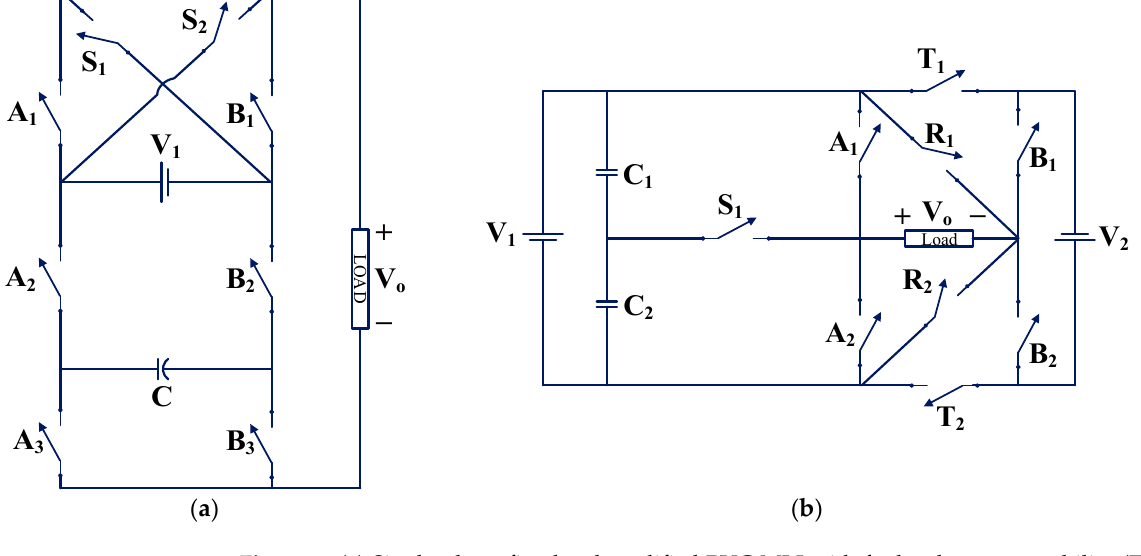
Figure 5. ( a ) Single-phase five-level modified PUC MLI with fault tolerance capability (TP3) [48]. ( b ) Single-phase seven-level modified symmetrical and asymmetrical MLI with fault tolerance capability (TP4) [48].